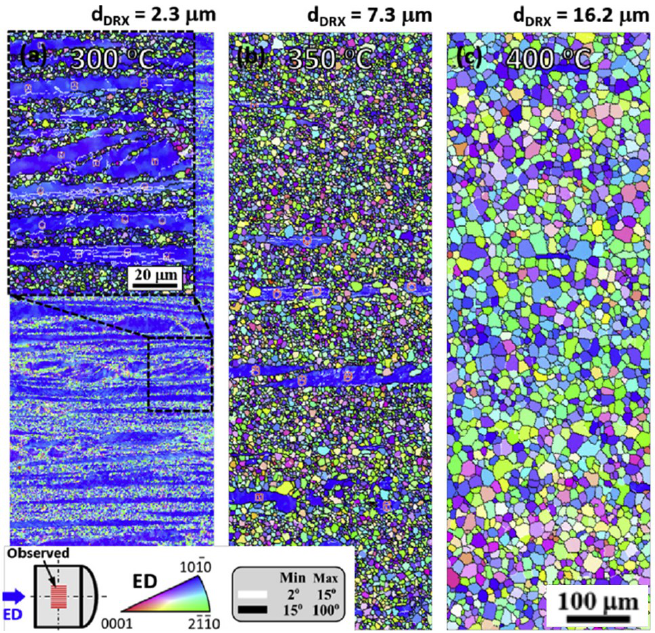
Figure 8. Microstructure and texture in an as-extruded Mg-0.2Zn-0.3Ca-0.1Mn alloy at rising process- ing temperatures: ( a )300 ◦ C, ( b )350 ◦ C, ( c )400 ◦ C [85]. Reprinted from Ref. [85] with permission; Copyright Elsevier